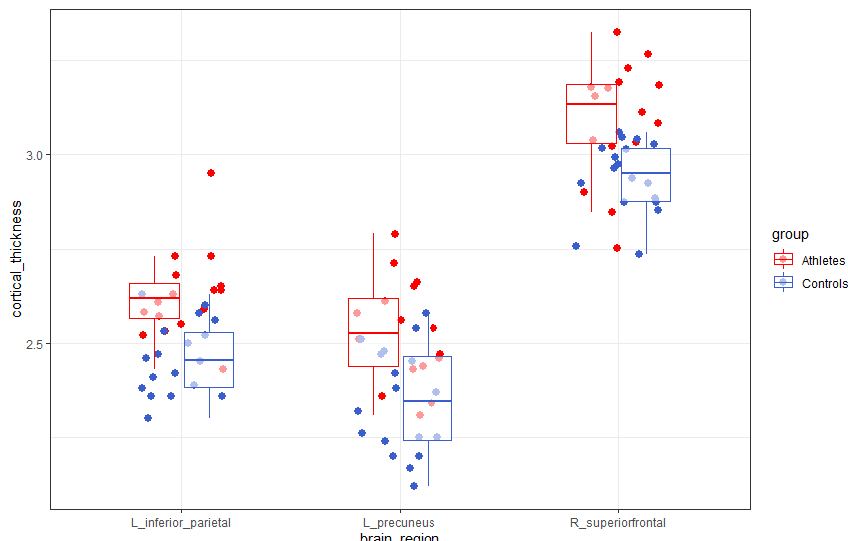
Figure 1. Parcel-wise difference of cortical thickness in the left precuneus, the left inferior parietal lobe, and the right superior frontal lobe between the athlete group and the control group. Data are presented by dot plots, whiskers, and box plots (median and error bars representing the first and third quartiles, respectively).